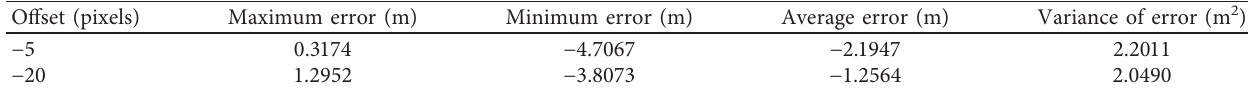
Figure 8: Distribution of errors in space headway estimation when different locating offsets are added to measurement points at different positions and different heights of the following vehicle: (a) offset of − 5 pixels and (b) offset of − 20 pixels. Table 3: Characteristics of space headway estimation errors when different locating offsets are added to measurement points at different positions and heights of the following